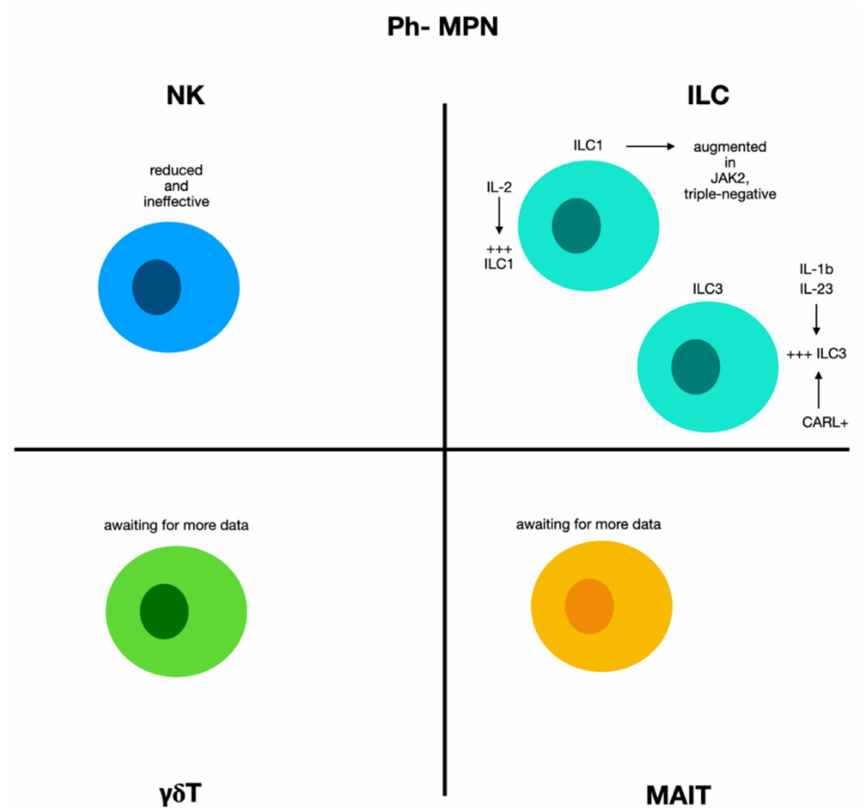
Figure 4. BCR-ABL-negative myeloproliferative neoplasms (Ph- MPN) unconventional immune cell scenario. NK: Ph- MPN patients have fewer NKs with altered function. ILC: ILC1 was augmented in JAK2-mutated and triple-negative patients, while ILC3 was increased in the CALR-mutated group. The ILC3 augment can be correlated with the increased concentration of IL-1b and